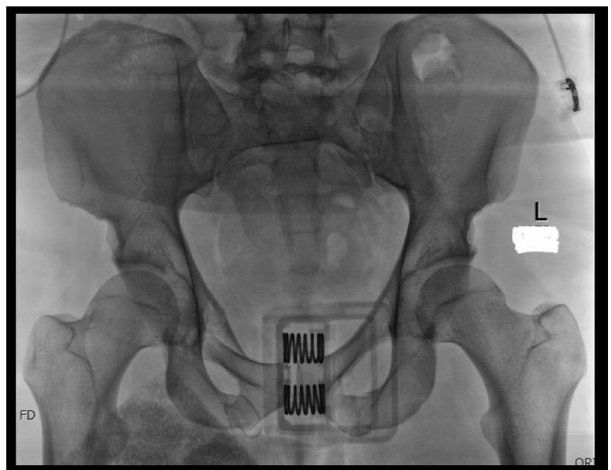
Figure 5. Straddle type fracture-bilateral public rami fractures with bilateral sacral fractures. Initial radiograph on arrival with binder on.